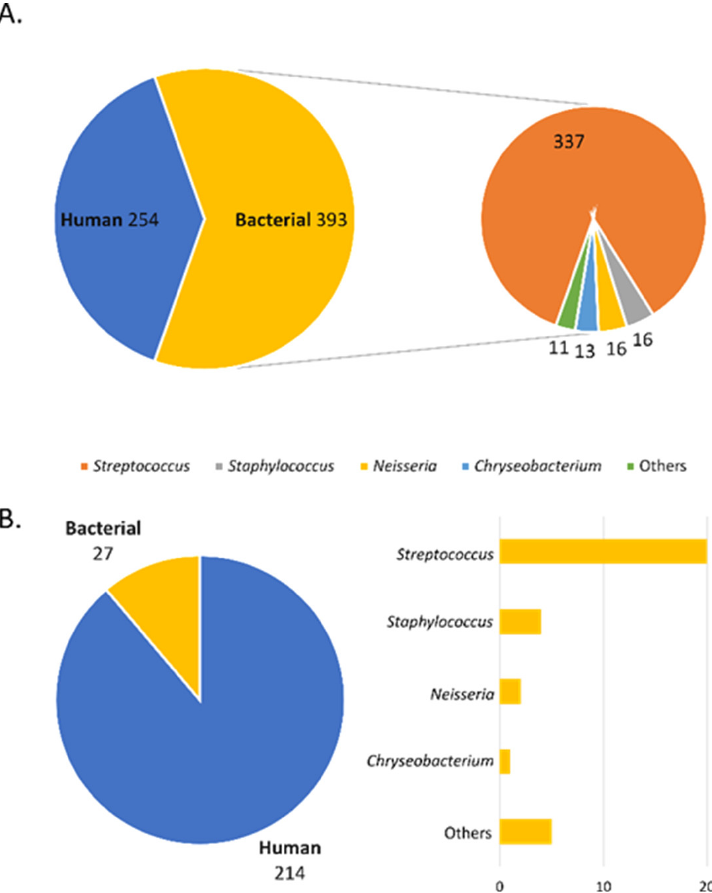
Figure 3. Pie charts with all identified proteins identified for human and bacterial databases: ( A ) total human and bacterial proteins; ( B ) proteins identified in groups specifying the type of bacteria in the bar chart.